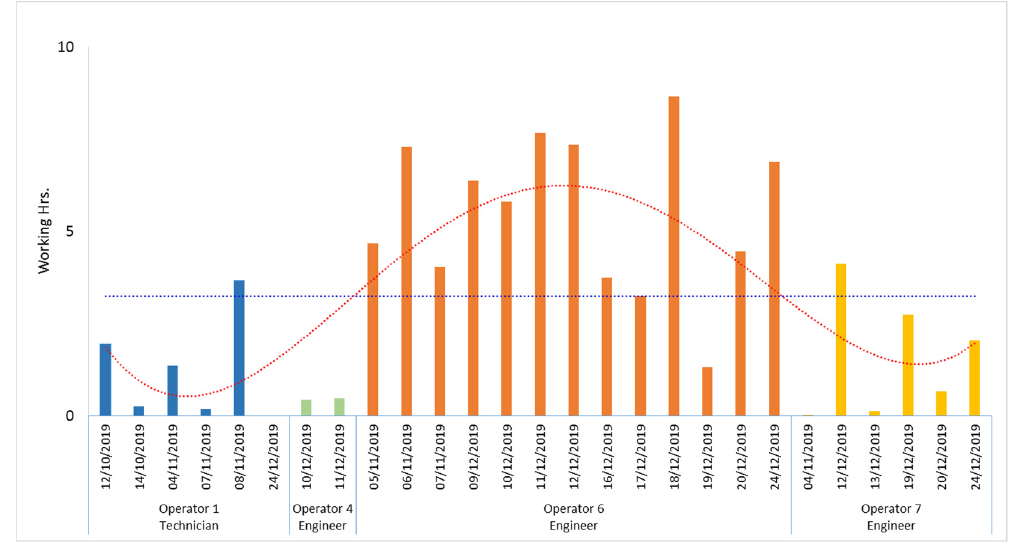
Figure 12. Customer 15, product type Complex Digital—Q4 2019.